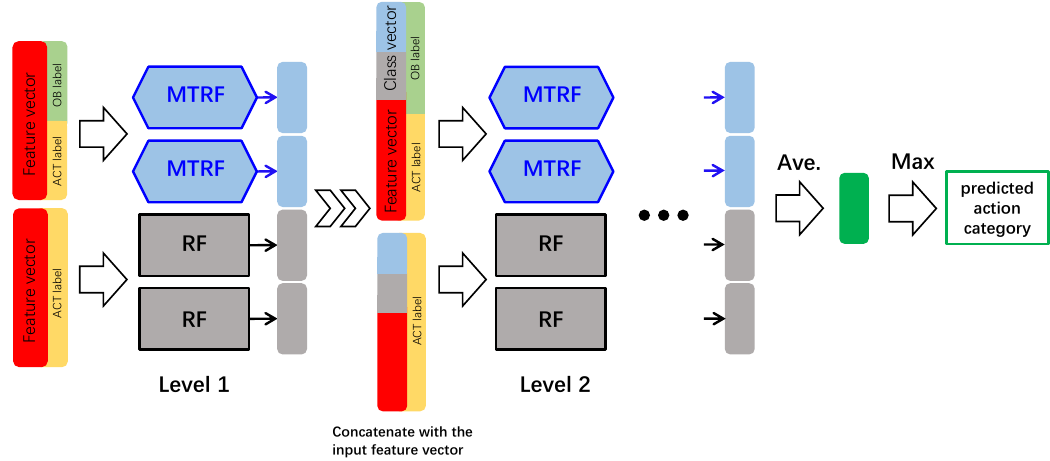
Figure 1. Overview of the proposed multi-task deep